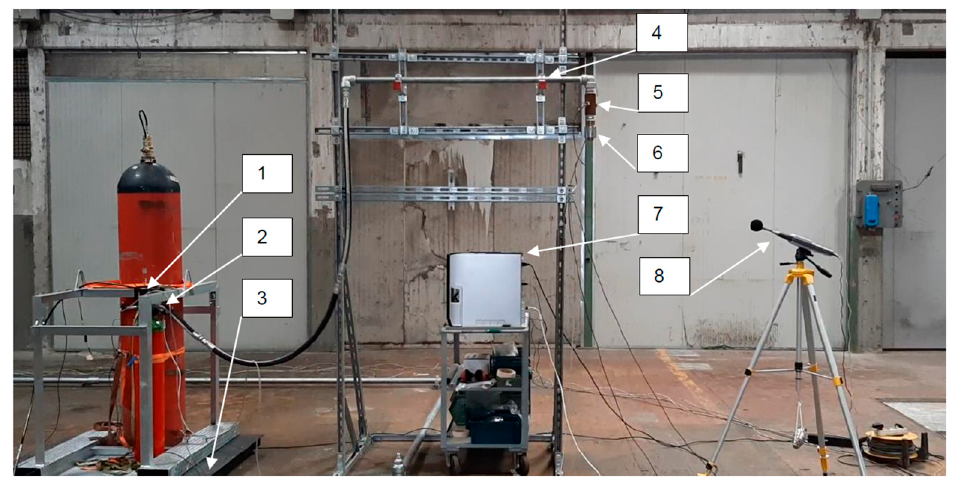
Figure 2. Photo of the experimental setup: ( 1 ) storage cylinder; ( 2 ) pressure transducer and thermocouple (downstream of the valve); ( 3 ) scale; ( 4 ) pipeline; ( 5 ) pressure transducer and thermocouple (upstream of the nozzle, only for inert gas discharge system); ( 6 ) nozzle; ( 7 ) servers, including one SSD and two HDD; ( 8 ) sound level meter.